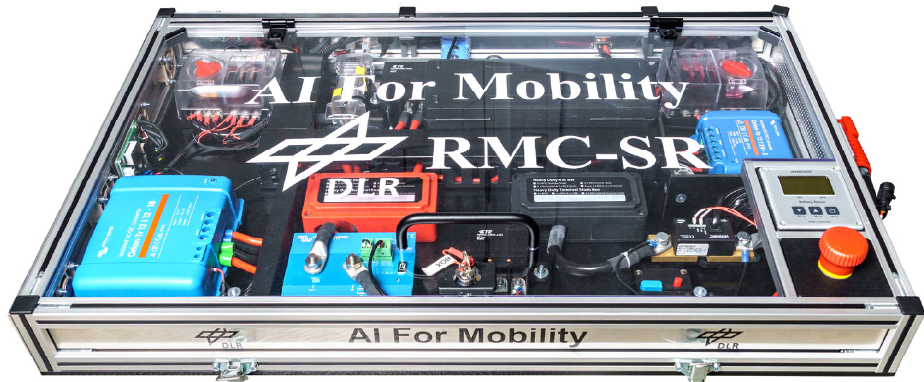
Figure 9. The E ‐ Box with all electrical components necessary for the operation of all auxiliary equip ‐